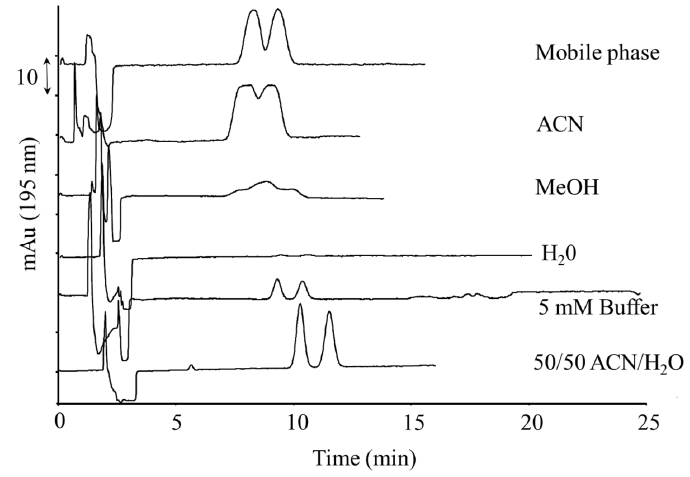
Figure 3. Effect of sample dilution solvent on the chromatographic profile of miconazole. Chromatographic conditions: 20 mM ammonium hydrogen carbonate (pH 9) in ACN/water (85/15, v / v ); flow rate: 400 nL min − 1 ; injection volume: 200 nL; sample concentration (racemic): 10 µg mL − 1 . For